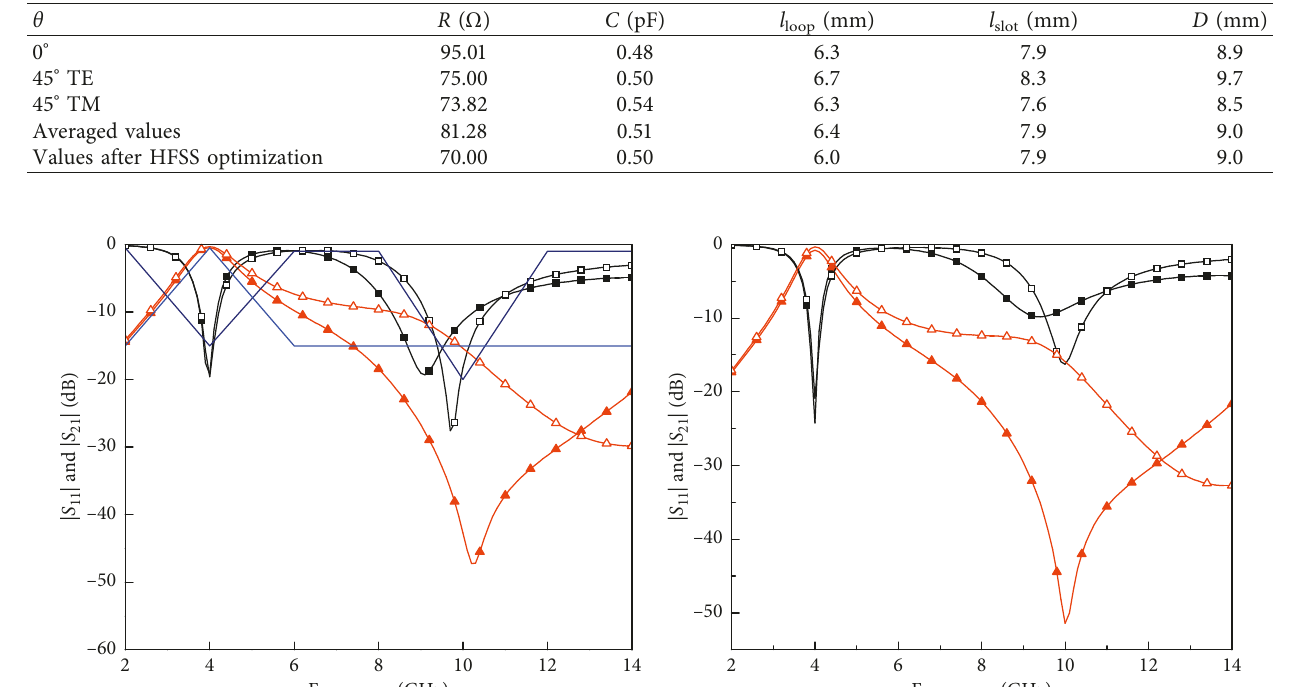
Table 4: Equivalent circuit and geometrical parameters calculated by the curve-fitting